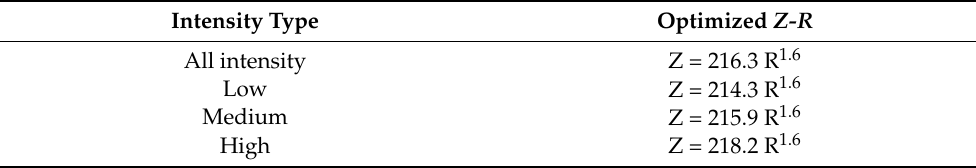
Table 2. α and β coefficients of newly established Z-R models for different rain